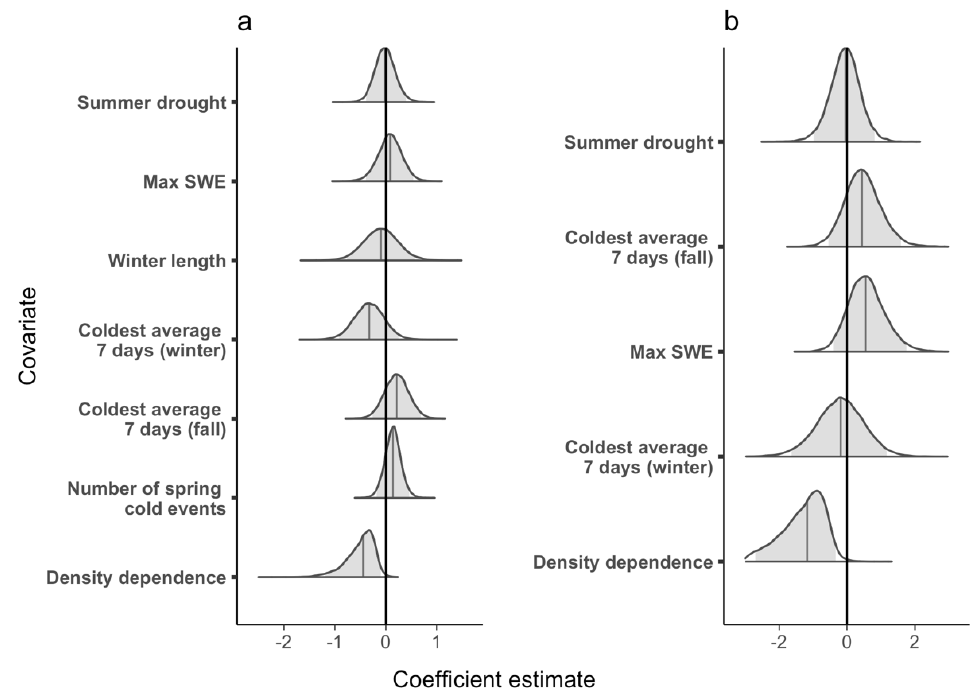
Figure 5. Matthews Pond: Posterior parameter distribution for each covariate included in models of ( a ) population growth rate and ( b ) survival. Shaded gray areas indicate the 95% credible intervals and solid lines within the posterior indicate the median value of the coefficient estimates. We considered a covariate significant if the 95% credible interval did not overlap zero.